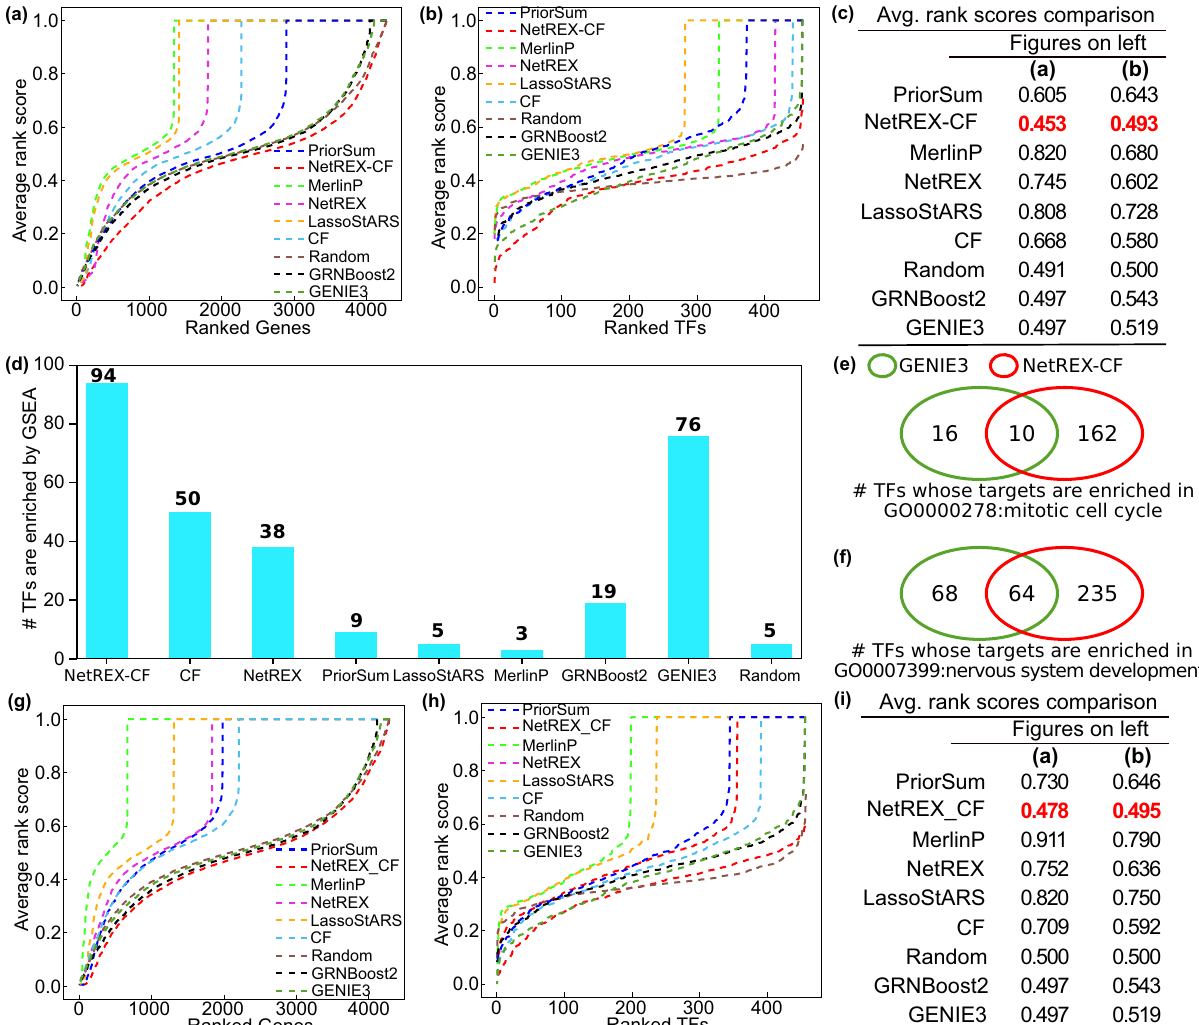
Fig. 4 Performance comparison for all competing algorithms on the S2 cell line. a The performance of the methods on the task of predicting regulating TFs: for each algorithm, we compute for each gene the rankings of edges in the benchmark dataset adjacent to it, sort them in descending order, and plot the sorted average rankings. b The performance of the methods on the task of predicting regulated genes using a measure similar to in ( a ) but focusing on genes regulated by TFs. c Summary of the average rank scores in ( a ) and ( b ). The lowest scores are highlighted in bold red. d The bar plot indicates the number TFs whose target genes in the benchmark dataset are signi fi cantly enriched at the top of the ranked gene list ( p value < 0.01 with 1000 random permutations), as predicted by each method in the GSEA analysis. e , f The Venn diagram between TFs is identi fi ed by the top two methods in ( b ): GENIE3 and NetREX-CF. The target genes of TFs shown in are enriched in the GO term of the mitotic cell cycle ( e ) and nervous system development ( f ), respectively. g – i The same plots as ( a ) and ( b ). The only difference is that all the competing methods do not use the ChIP